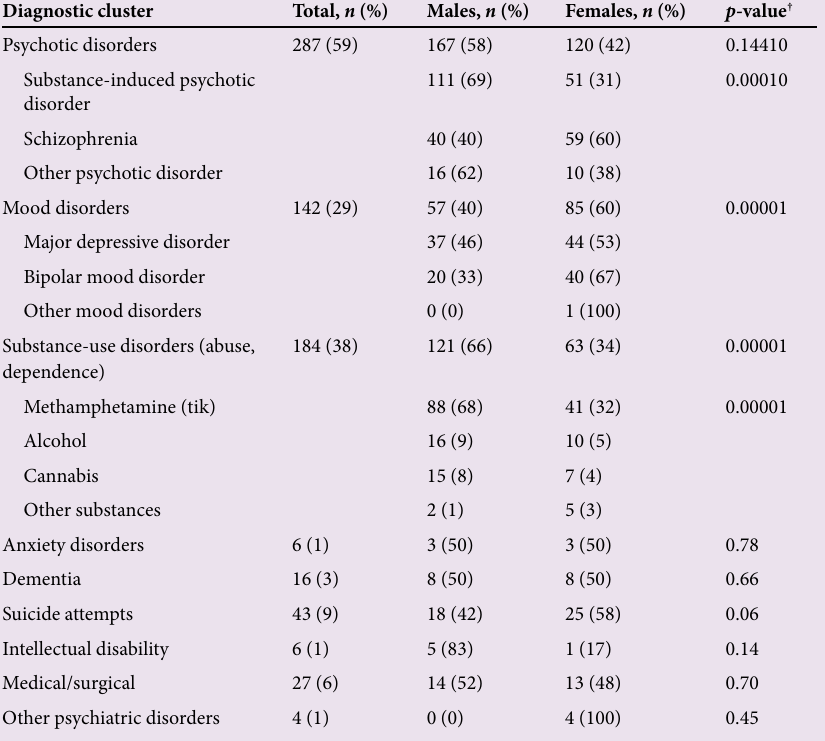
Table 2. Outcome data of mental health- care users (total admission